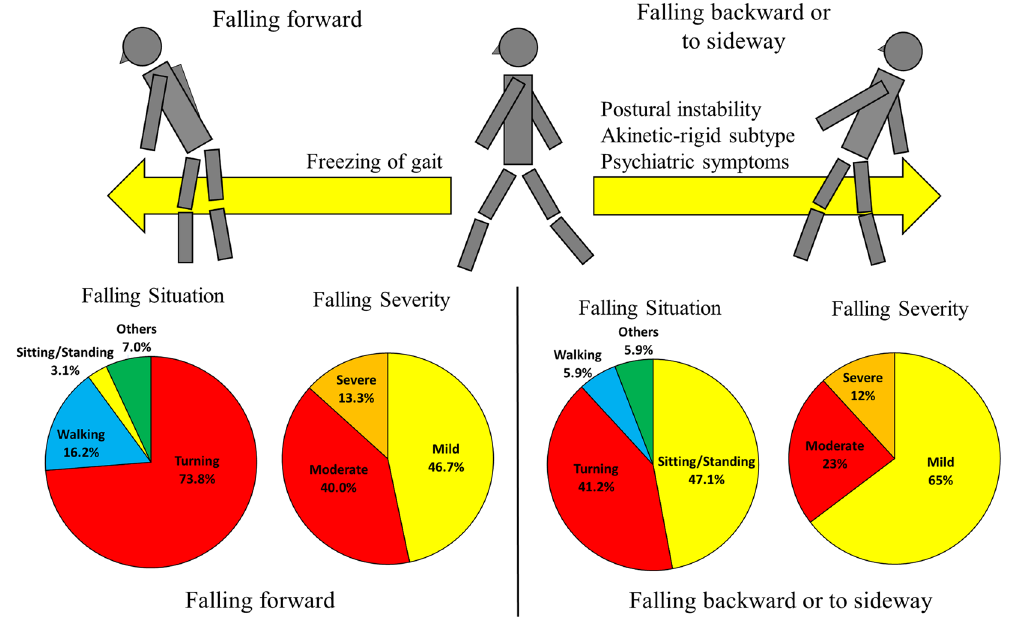
Figure 1. Scheme of the mechanism and characteristics of PD forward fallers and non-forward fallers. Falling forward was related to freezing of gait, while balance impairment, akinetic-rigid subtype, and neuropsychiatric symptoms were associated with falling backwards or sideways. In terms of falling situations, forward fallers tended to fall during walking and turning, while non-forward fallers mainly fell during walking and sitting/ standing. Additionally, non-forward fallers had more frequent mild falls, and less moderate falls compared with forward fallers.